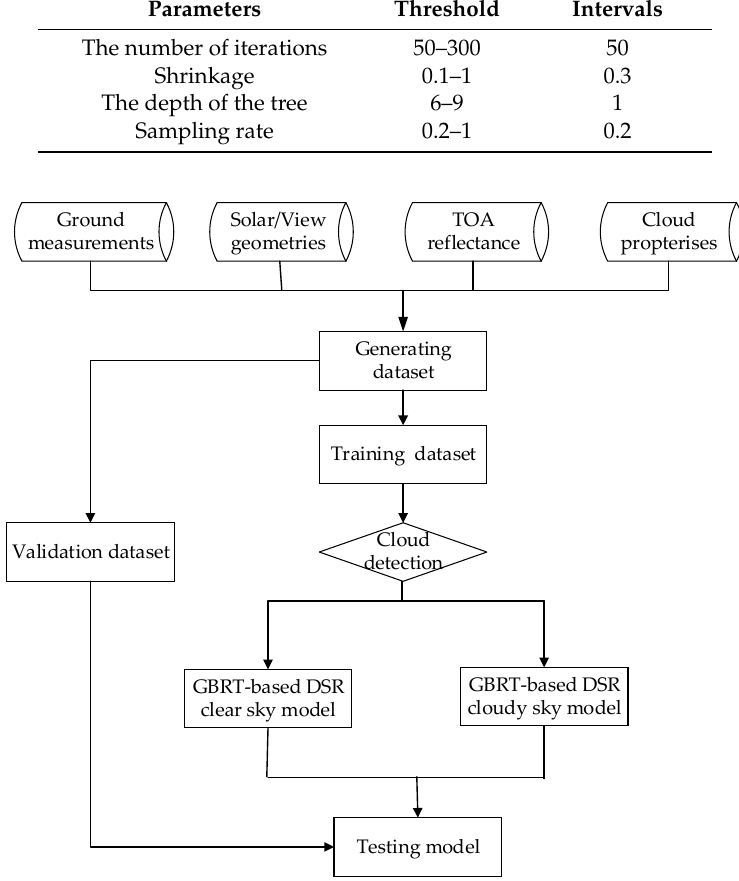
Table 2. Parameters setting to determine the optimal parameters for the GBRT model.